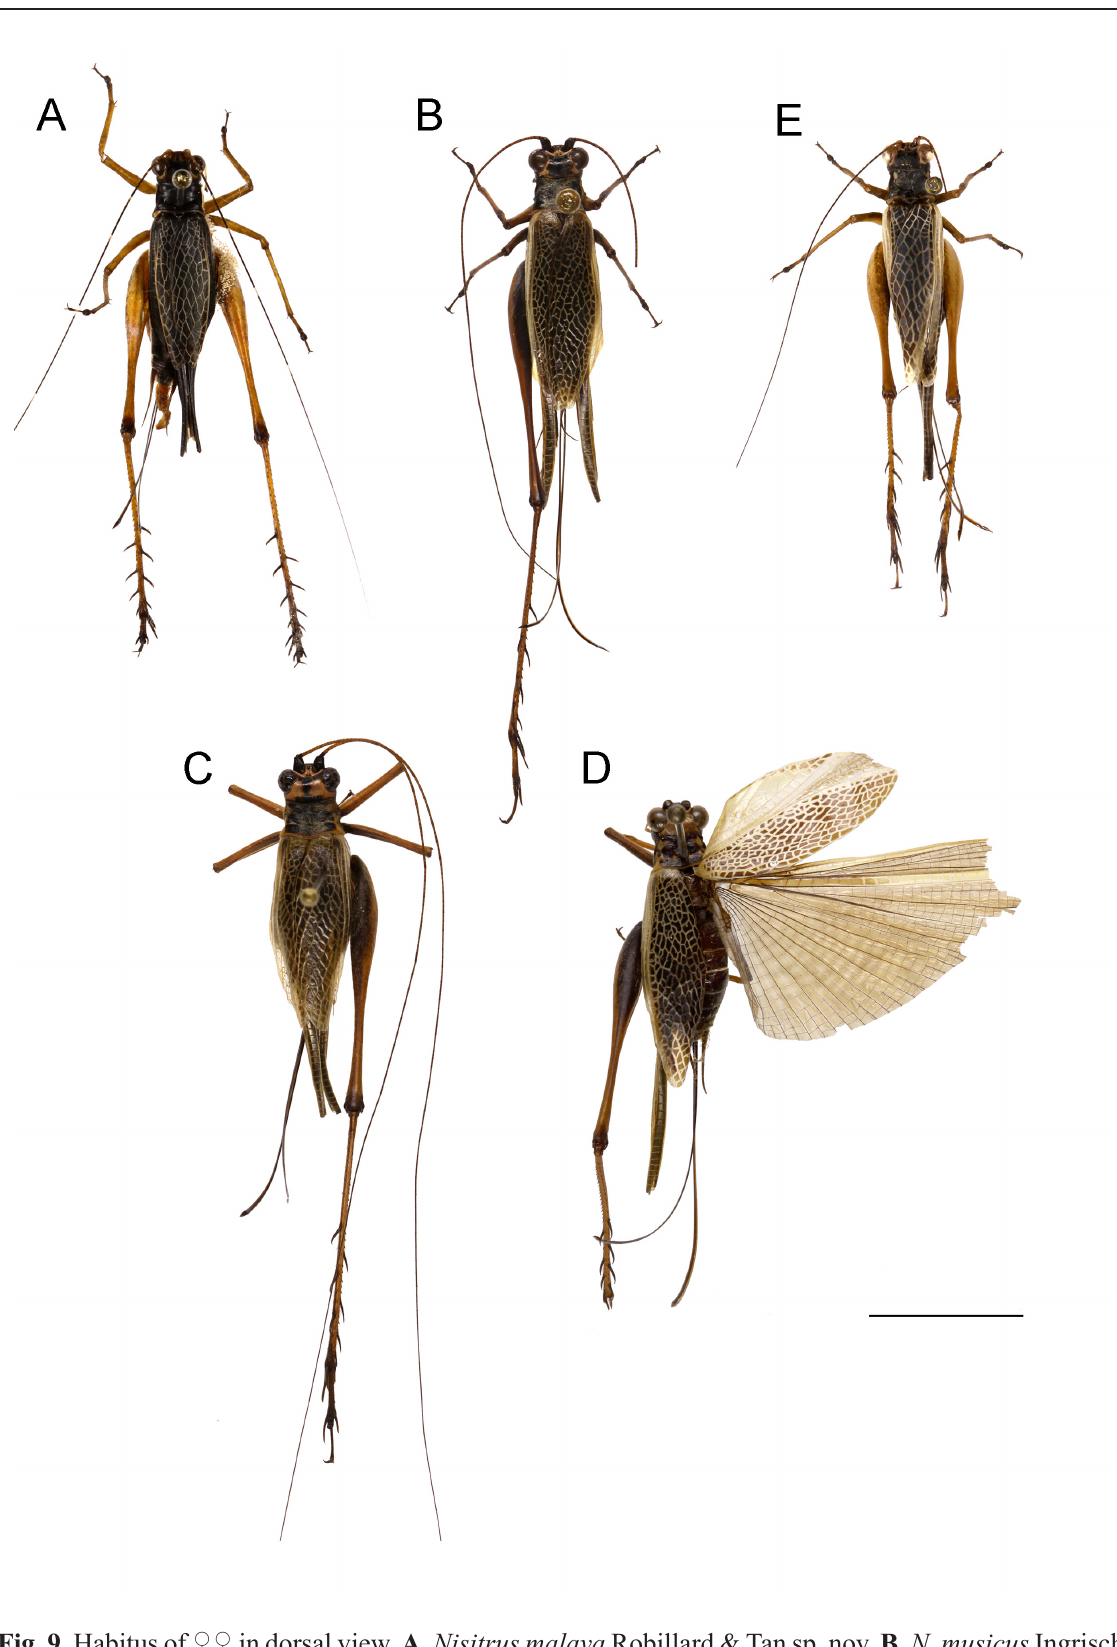
Fig. 9. Habitus of ♀♀ in dorsal view. A . Nisitrus malaya Robillard & Tan sp. nov. B . N. musicus Ingrisch, 1987. C–D . N. rindu Robillard & Tan sp. nov. E . N. vittatus (Haan, 1844). Scale bar = 10